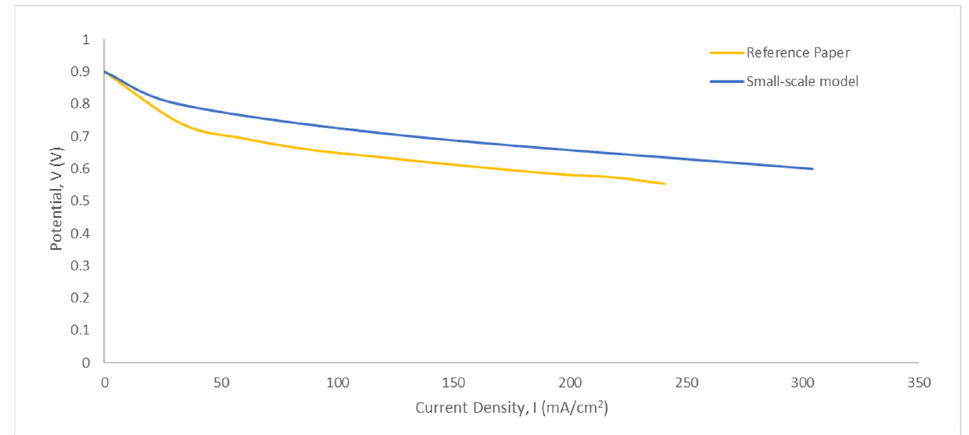
Figure 3. Polarization curve of current simulation and reference paper [27].